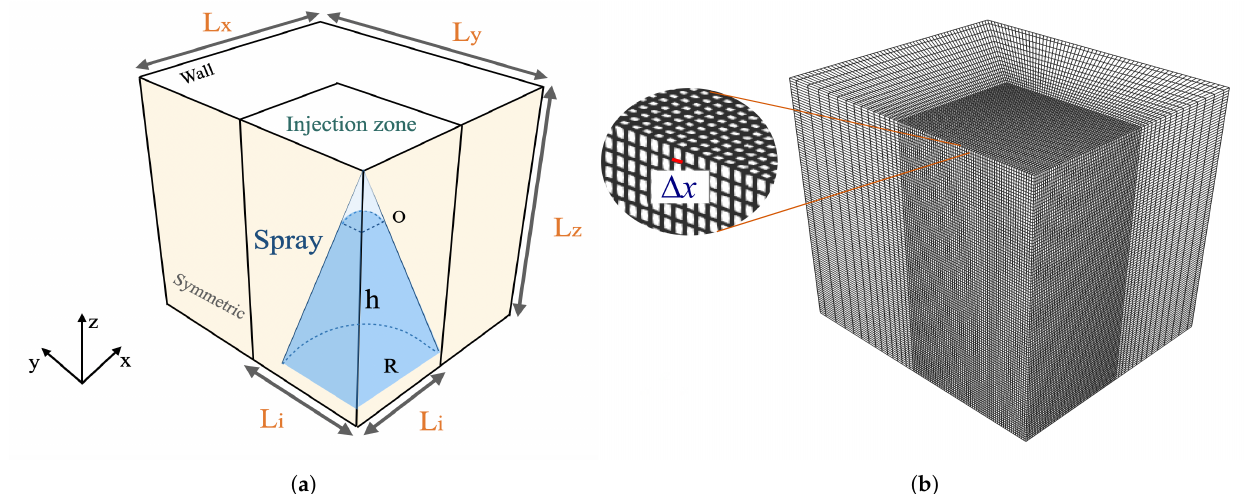
Figure 3. Geometry and mesh grid of a single spray nozzle: ( a ) a sketch of the geometry and spray nozzle position; ( b ) a grid of mean mesh size ∆ x = 1.5 cm in the injection zone L i = 1.5 m; L x = 3.5 m, L y = 3 m, and L z = 3.5 m; with O the numerical injection plane; symmetric and wall boundary conditions